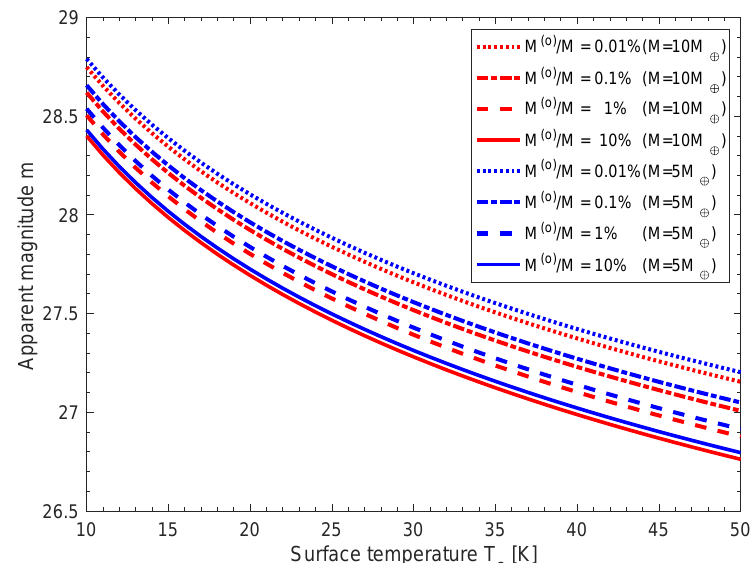
Figure 1. The predicted apparent magnitude of the P9. M is the total mass of the